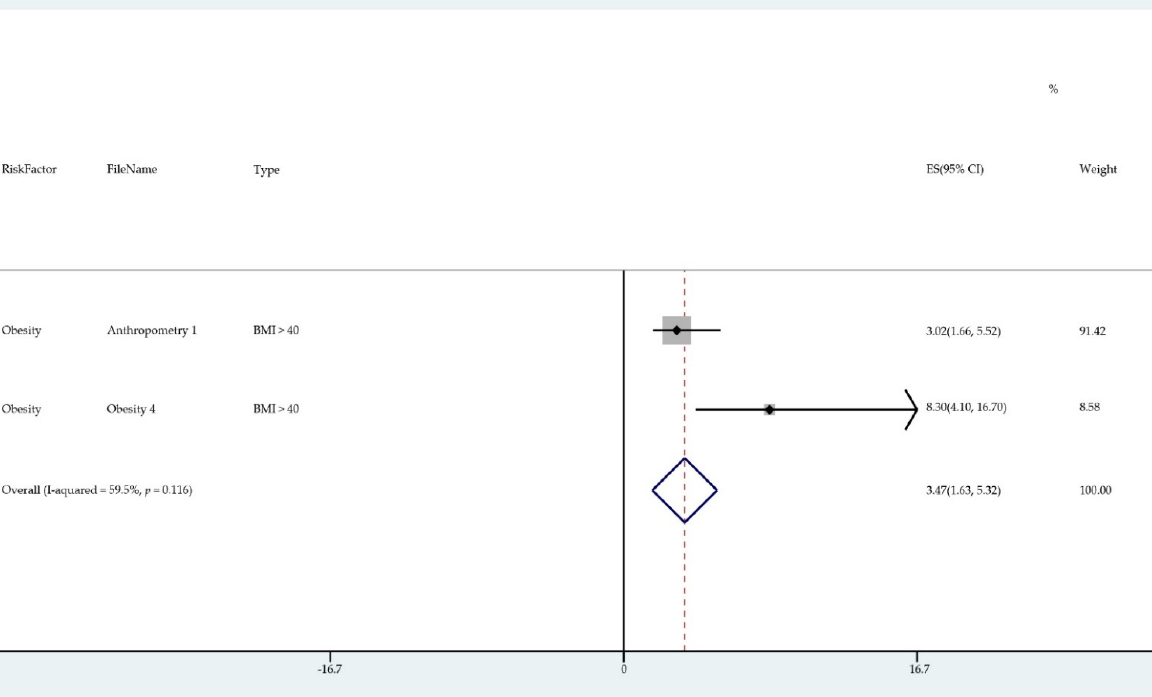
Figure 3. Forest plot to show risk of BMI > 40.